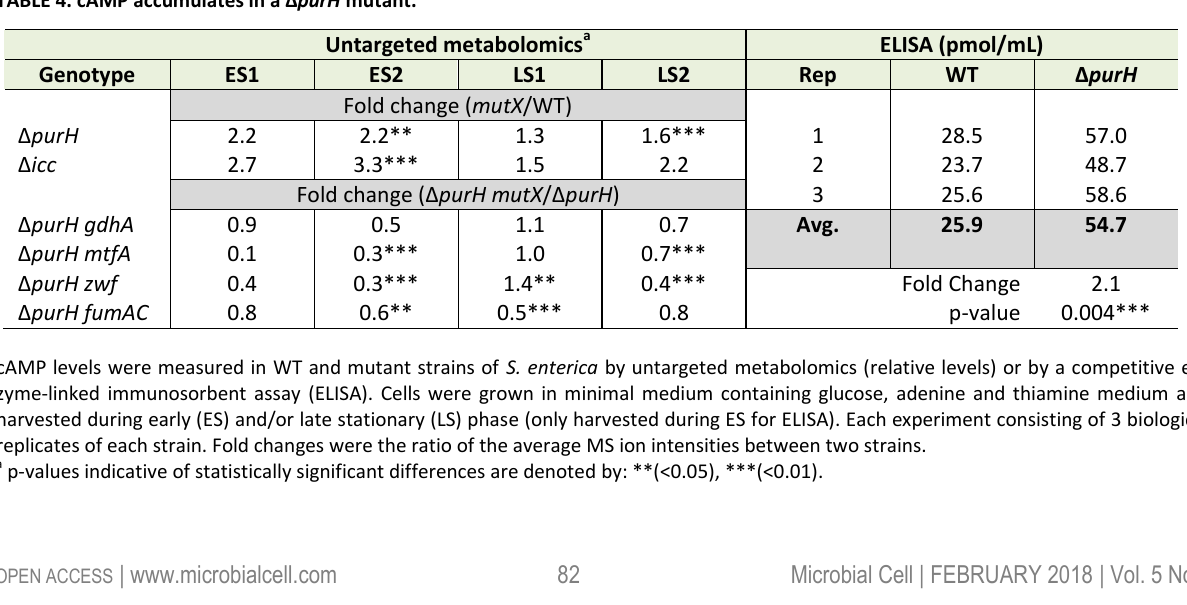
TABLE 4. cAMP accumulates in a Δ purH